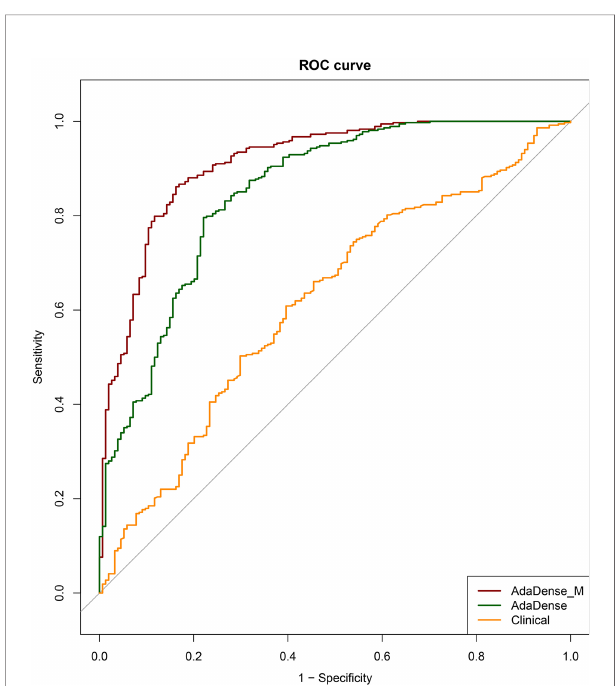
FIGURE 2 | The ROC curves of the CNN models for malignancy prediction. The ROC curves of the AdaDense_M (CNN incorporated with different window images and segmentation mask), AdaDense (CNN only with the lung window image as input), and baseline clinical model (diameter) for malignancy prediction in the testing dataset. The three models ’ corresponding AUCs were 0.913, 0.848, and 0.618, respectively. DeLong tests showed that the AdaDense_M performs signi fi cantly better than the AdaDense model and the clinical model (p<0.001).